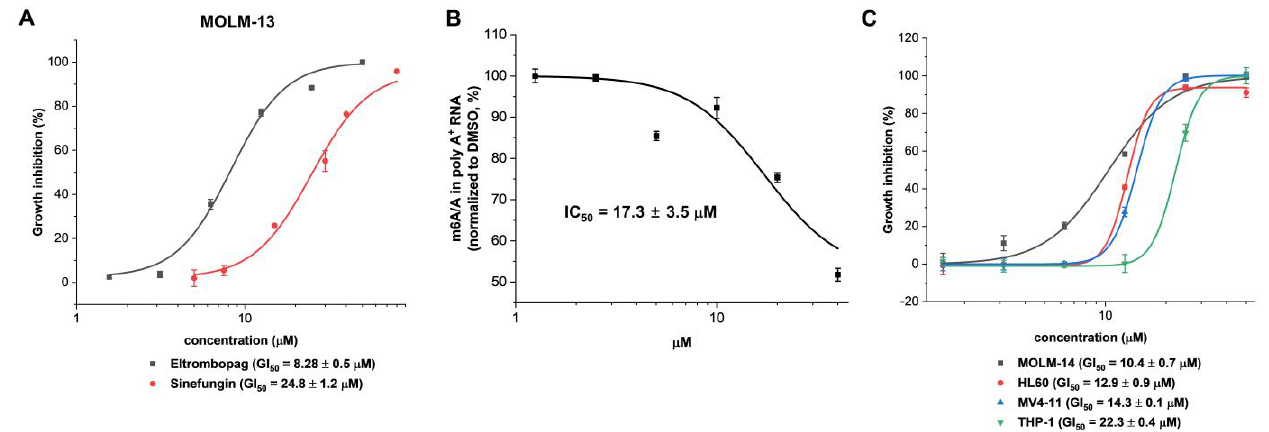
Figure 7. Anti-proliferative activity and cellular activity of eltrombopag on AML cell lines. ( A ) Anti-proliferative activity of eltrombopag against the MOLM-13 cell line. A global methyltransferase inhibitor, Sinefungin ( 1 ), was evaluated as a positive control in MOLM-13 cell line with a GI 50 value of 24.8 μ M. (Gilteritinib, an FLT3 targeted anti-AML drug, showed a GI 50 value of 16.6 nM in Figure S3). ( B ) Dose-response curve of m 6 A/A reduction on poly-A + -enriched mRNA after 24 h of MOLM-13 treatment with eltrombopag. ( C ) Anti-proliferative activities of eltrombopag against AML cell lines including MOLM-14, HL60, MV4-11, and THP-1 cell lines.